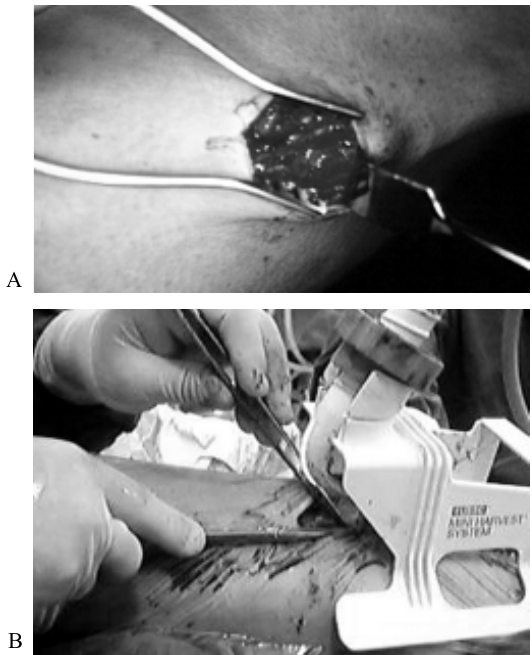
Fig. 1 A-Dissecção com uso de afastadores de Langenbeck.